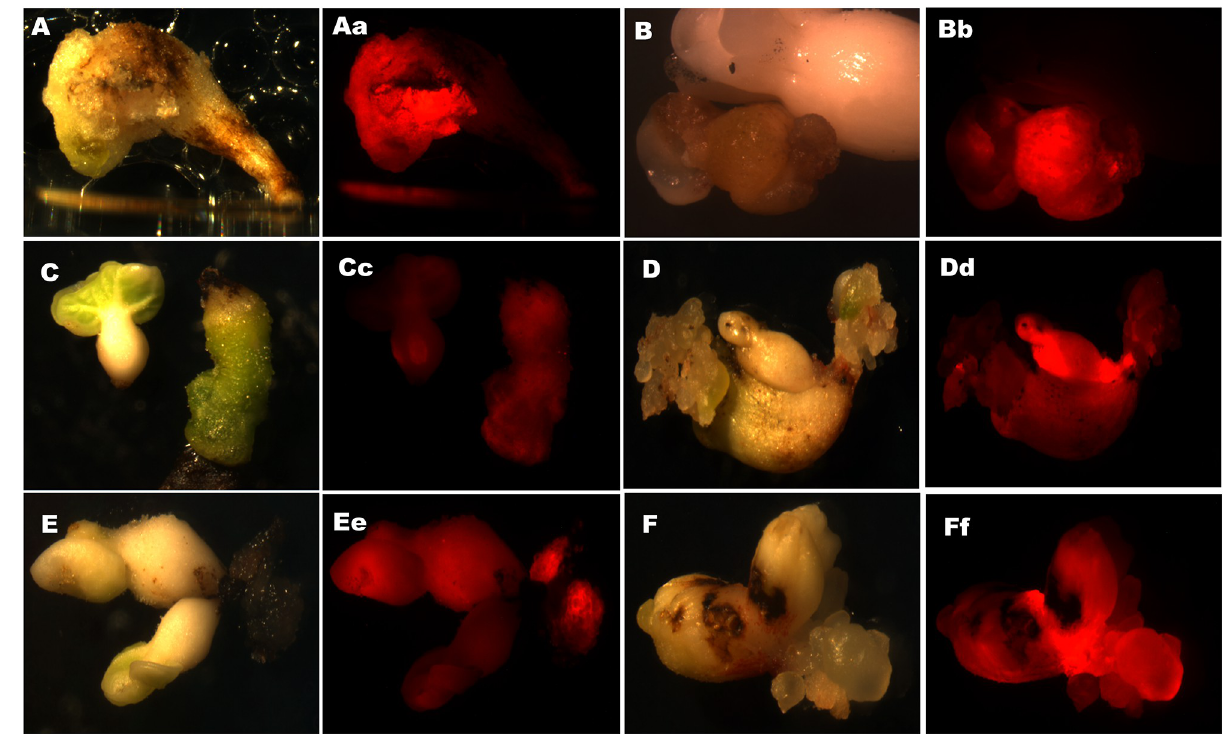
Fig 4. Cotton embryos comparable under white light and DS-Red. (Portion of embryos expressing strong DS-Red fluoresce to red color under stereomicroscope. Fluorescent embryos growing from highly fluorescent calli were considered as true transgenic embryos (D, E and F). DS-Red (transgene) was observed transferring from callus to embryos and ultimately transferred to roots and shoots).